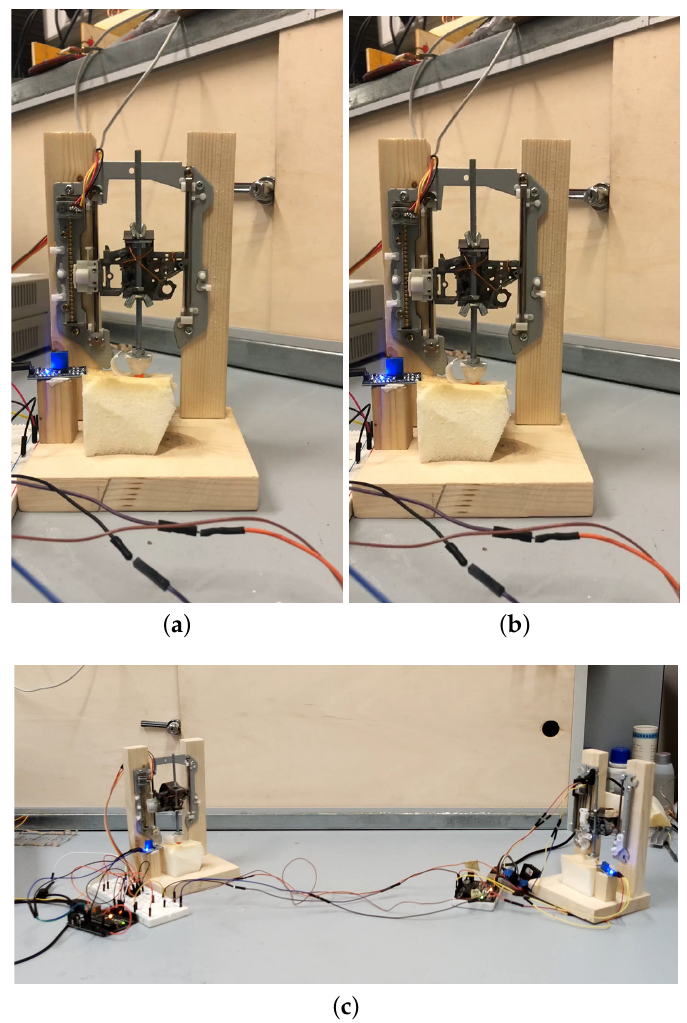
Figure 4. Experimental evaluation of demo 2: the two stations are linked through an Arduino microcontroller implementing the control action and the transmission delay. ( a , b ) The actuator pushes the foam with different intesities, ( c ) complete setup with the two actuators representing the local and remote station performing the same pressure thanks to the control action. The time-scales are in the order of a few